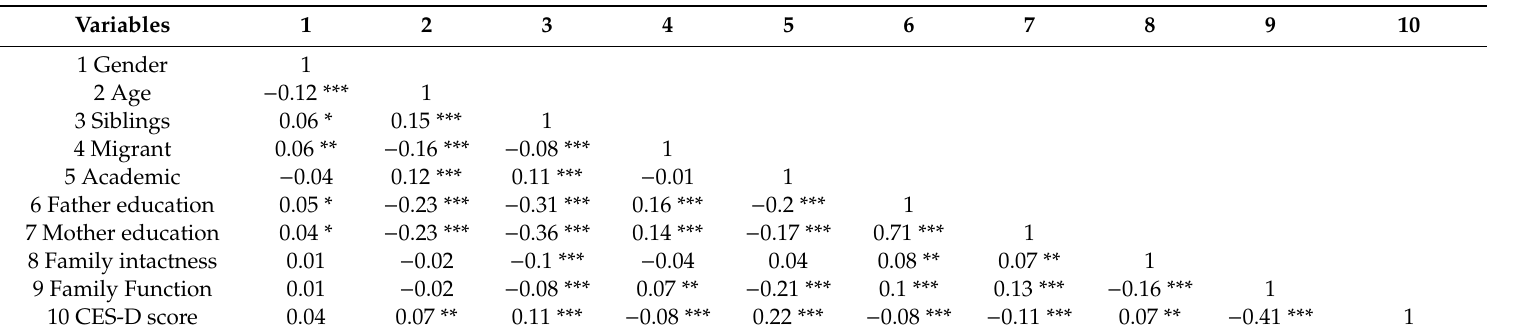
Table 3. Correlation analysis of variables in early